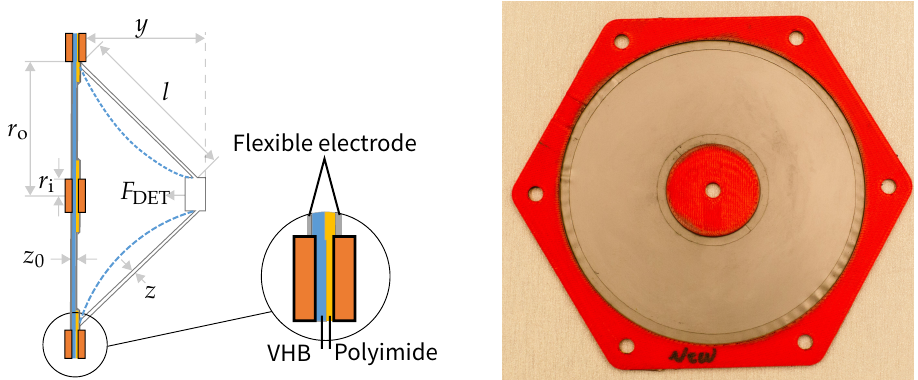
Figure 2. Cone-diaphragm DET configuration. The DETs used in this work were cone-diaphragm modules as depicted in photograph on the right. When a module’s center disk is displaced, the elastomer film deforms into the curved-cone shape depicted by the dashed lines in the left diagram. For modeling purposes, the deformed shape is approximated as a straight-sided cone depicted by the solid outline in the left diagram.